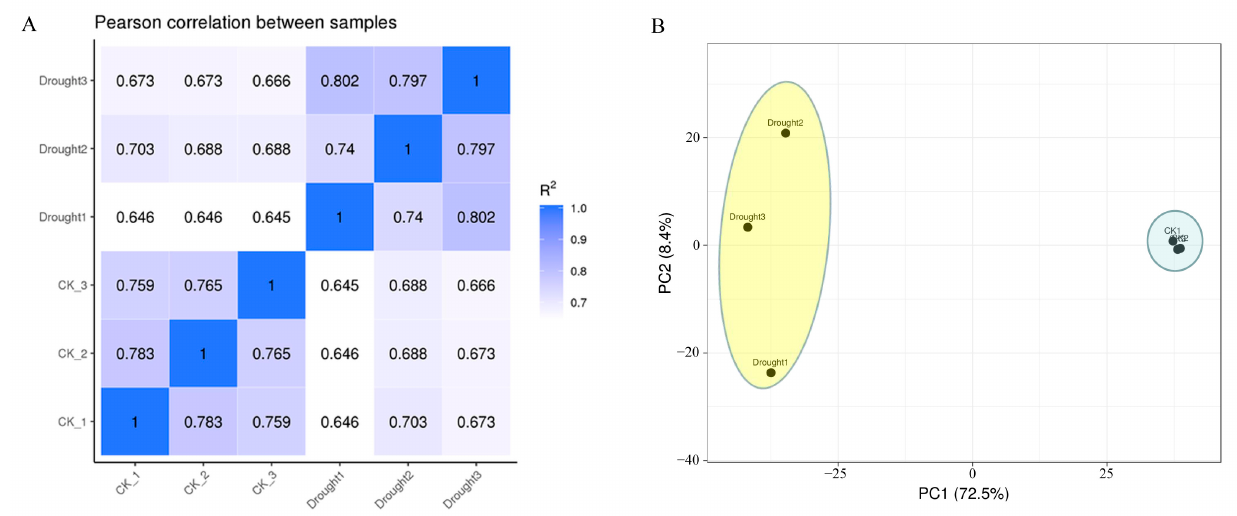
Figure 3. The Pearson correlation coefficient ( A ) and principal component analysis ( B ) of B. striata under CK and drought stress. Table 2. Annotations of unigenes in various Table 1. Summary of transcriptomes in B. striata under drought stress.